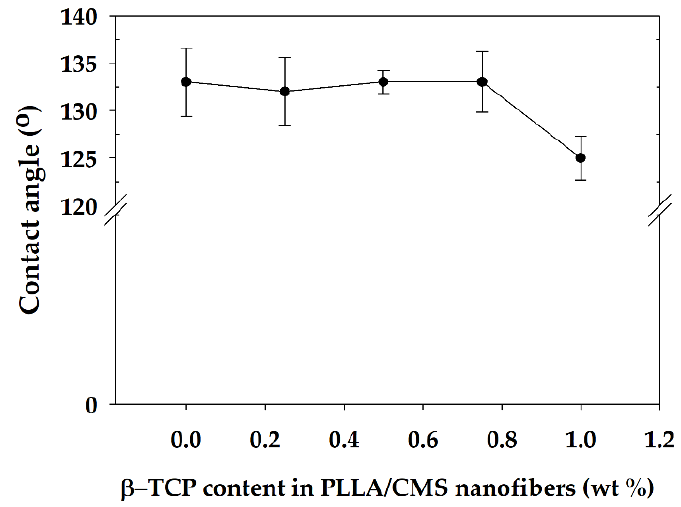
Figure 12. Water contact angle (WCA) of PLLA/CMS nanofibers at different contents of β